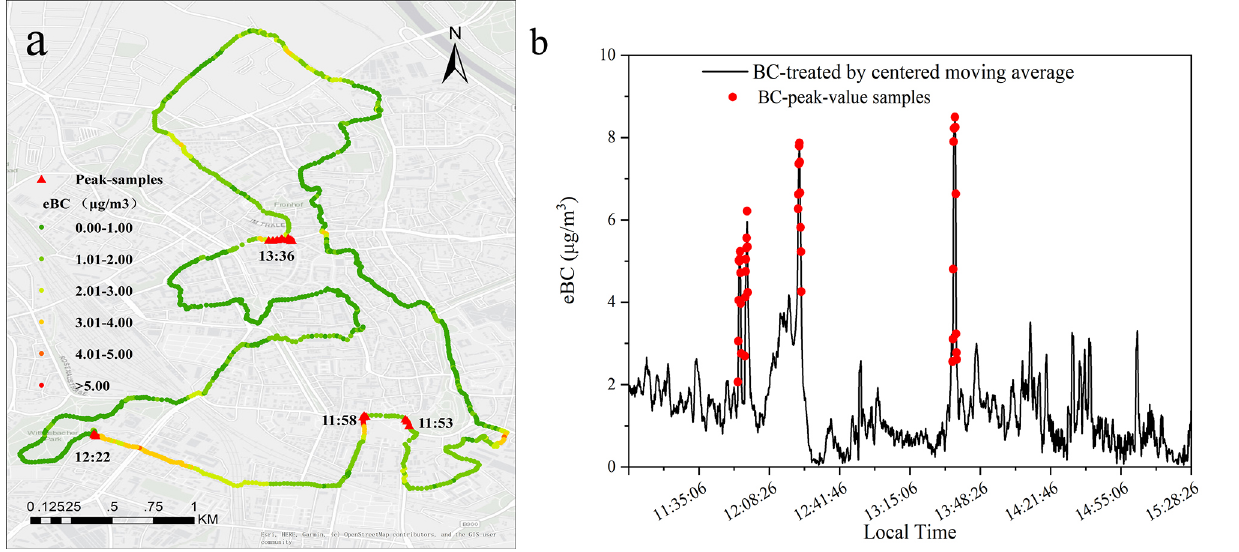
Figure 2. Identification of the spatial (a) and temporal (b) distribution characteristics of black carbon peak samples based on the coefficient of variation method (the analysis based on measurement 4); © OpenStreetMap contributors 2020. Distributed under the Open Data Commons Open Database License (ODbL)